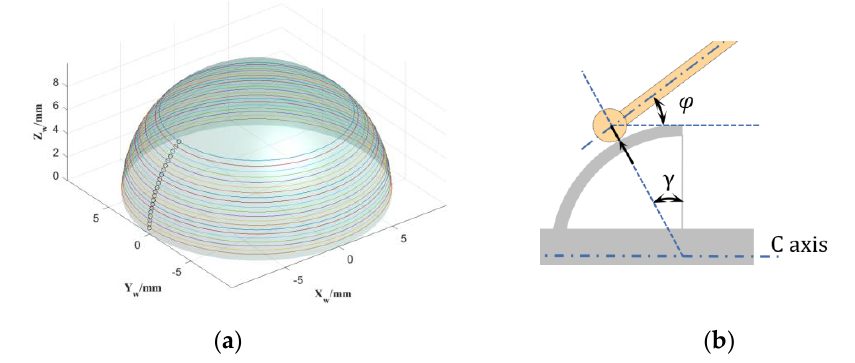
Figure 7. ( a ) Sampling trajectory for separating warp and weft; ( b ) correction of probe leverage. The concentricity of the inner and outer spherical surfaces is obtained by calculating the relative positions of the two spherical centers after measuring the profile of the inner and outer spherical surfaces. As shown in Figure 8, the coordinates of the point on the outer spherical surface of the workpiece in the S 1 CS coordinate system of Posture 1 are P i ,1 ( x i ,1 , z i ,1 ). The coordinates of the points on the inner spherical surface in the S 2 CS coordinate system of Posture 2 are Q j, 2 ( x j ,2 , z j ,2 ). According to Equation (3), we can transform the points of the inner sphere from the coordinate system of Posture 2 to Posture 1: where i = 1, 2, ..., m, j = 1, 2, ..., n. m, n is the number of sampling points, and ∆ C is calculated by Equation (4). We fitted the measurement point sets P i ,1 and Q j ,1 of the inner and outer spheres, respectively, using the least squares method. Next, we obtained the best-fitting sphere center position of the inner and outer spheres and calculated the concentricity.